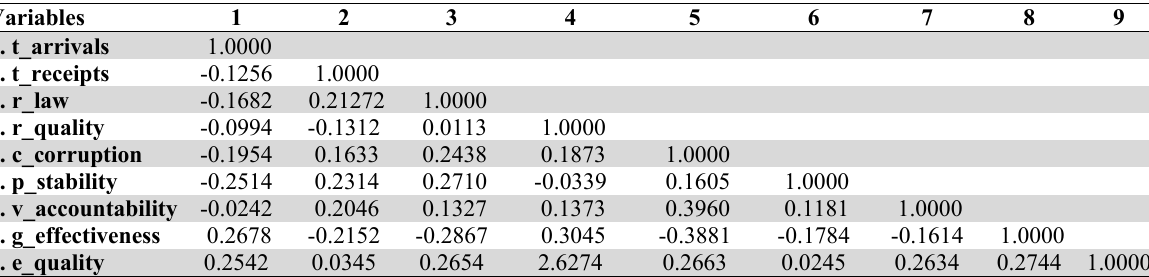
Correlation Matrix